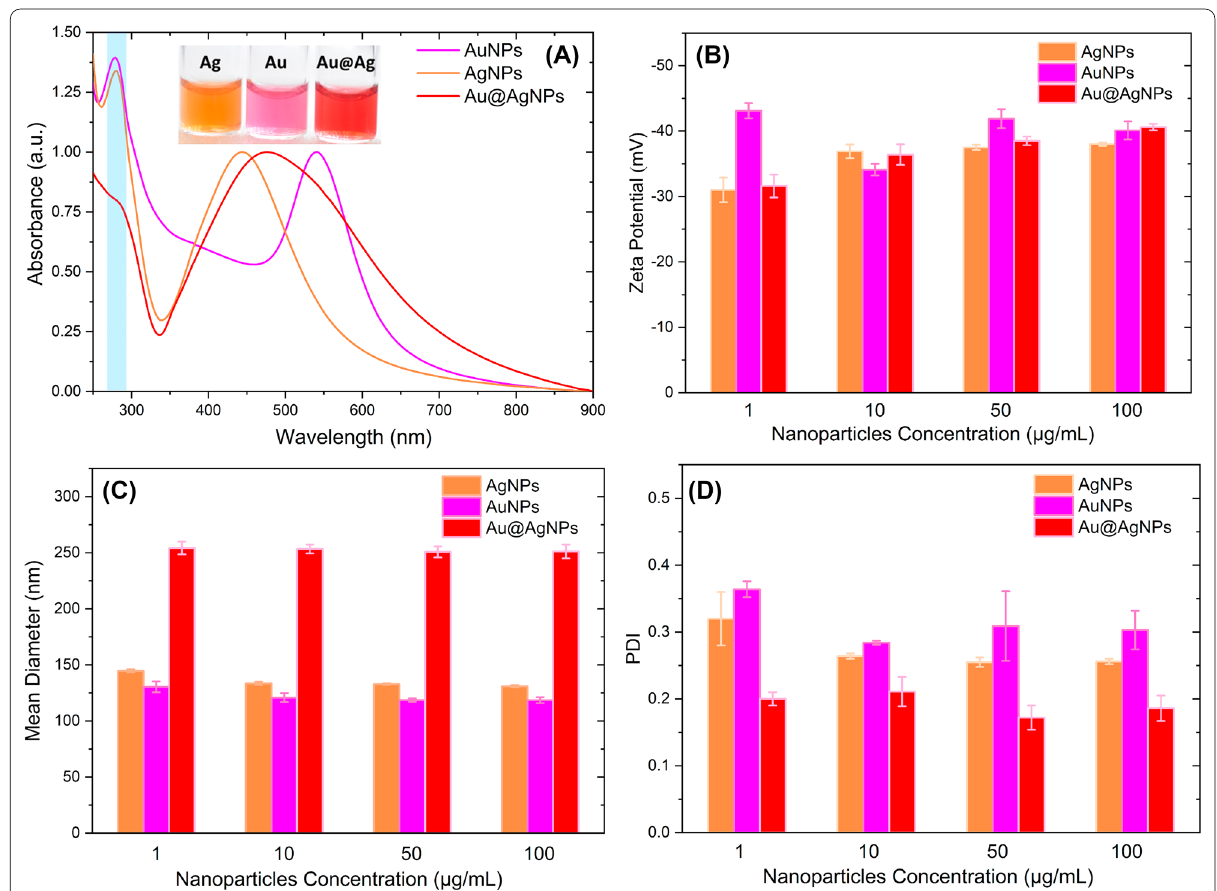
Fig. 1 Nanoparticles UV–Vis spectra ( a ), Z‑Potential ( b ), DLS ( c ), and PDI ( d ) of Au, Ag and